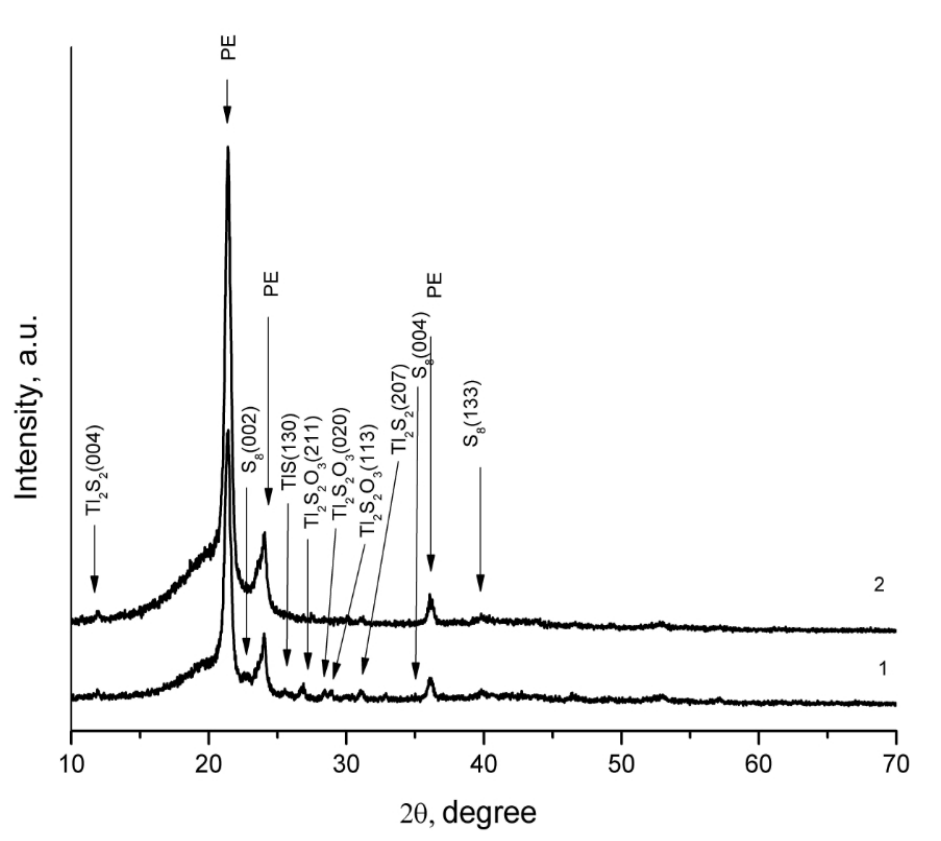
Figure 5. X-ray diffraction patterns of thallium sulfide layers on the surface of PE. PE initially treated with a solution of H